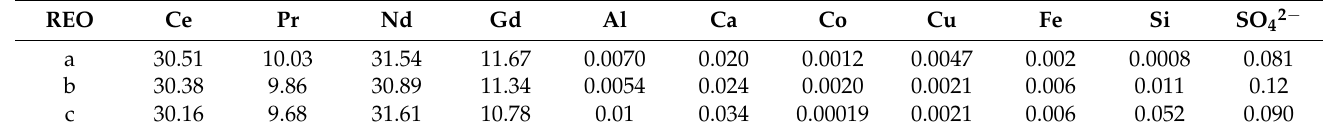
Figure 15. SEM-EDS images of REE calcination products. RE 2 (C 2 O 4 ) 3 ·10H 2 O ( a – b ); RE 2 (CO 3 ) 3 ·8H 2 O ( c – d ); RE(OH) 3 ( e – f ). Table 2. Chemical composition of RE x O y (mass, %).